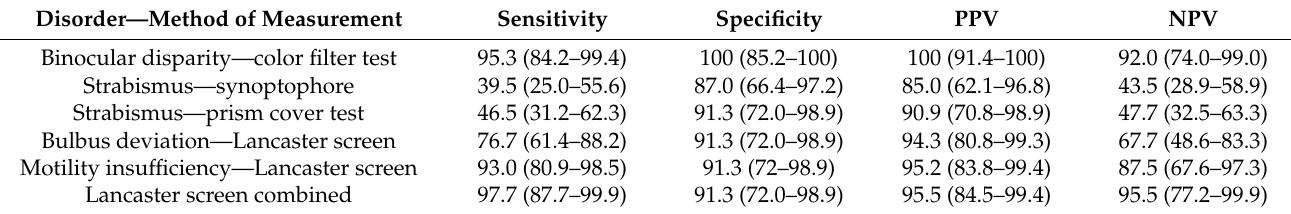
Table 1. The performance of individual tests from the battery of orthoptic examinations in detecting ocular motility disorders resulting from OFBF (complex combined evaluation used as a reference value, results are presented as estimates with 95% confidence intervals in